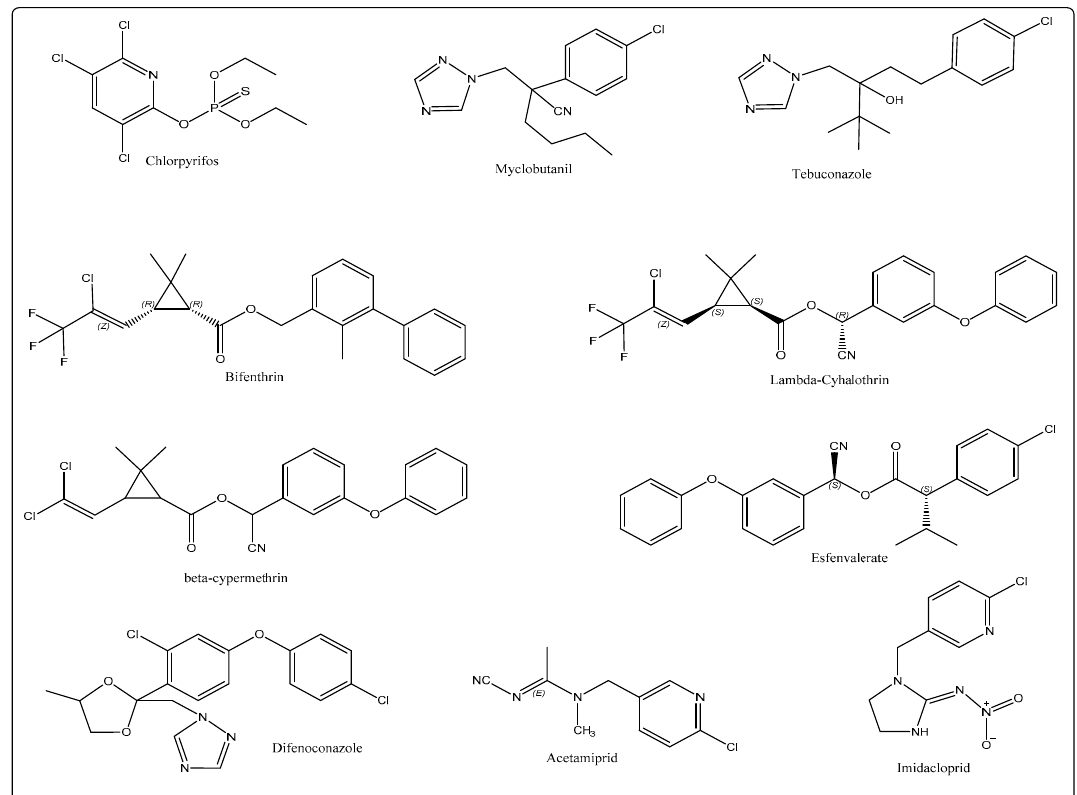
Figure 1. The chemical structures of the studied pesticides.